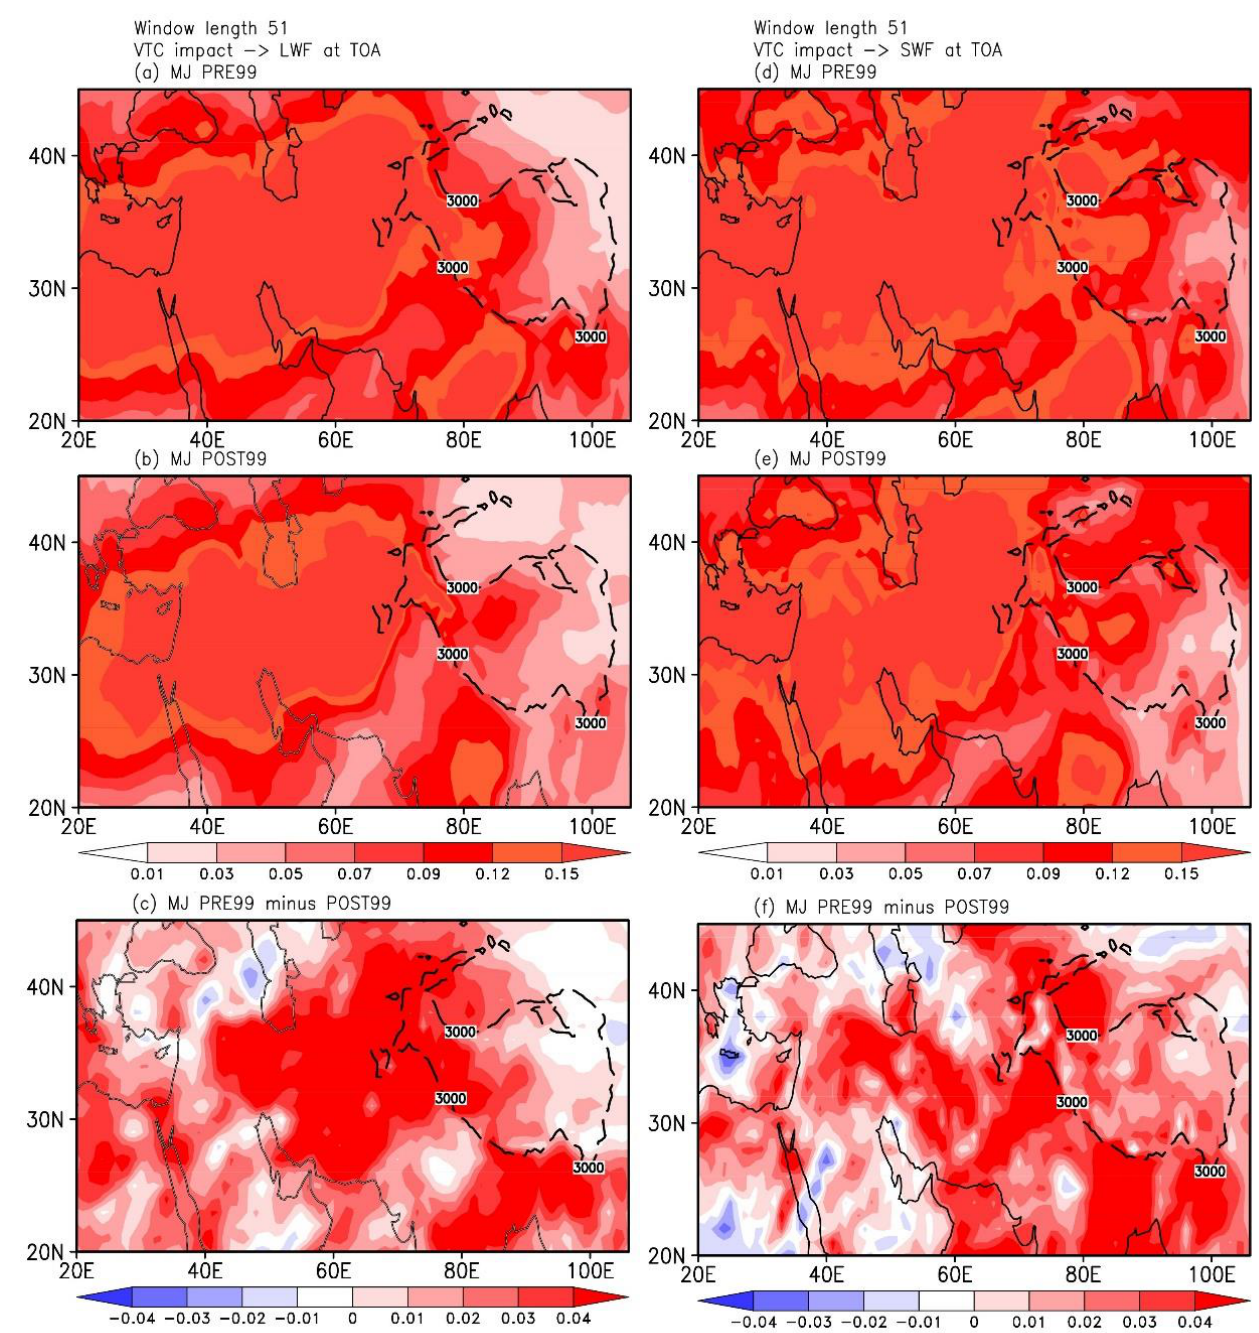
Figure 8. The causation (information flow in nats/day) from the TT thermal contrast (i.e., MJ Air temperature 250 hPa–100 hPa) over Region I to LWF at the top of the atmosphere for the time windows size of 51 ( a ) PRE99 and ( b ) POST99, respectively. ( c ) Difference ( a ) from ( b ), i.e., (a) − (b). The selections ( d – f ) are identical to ( a – c ), but SWF was chosen rather than LWF.